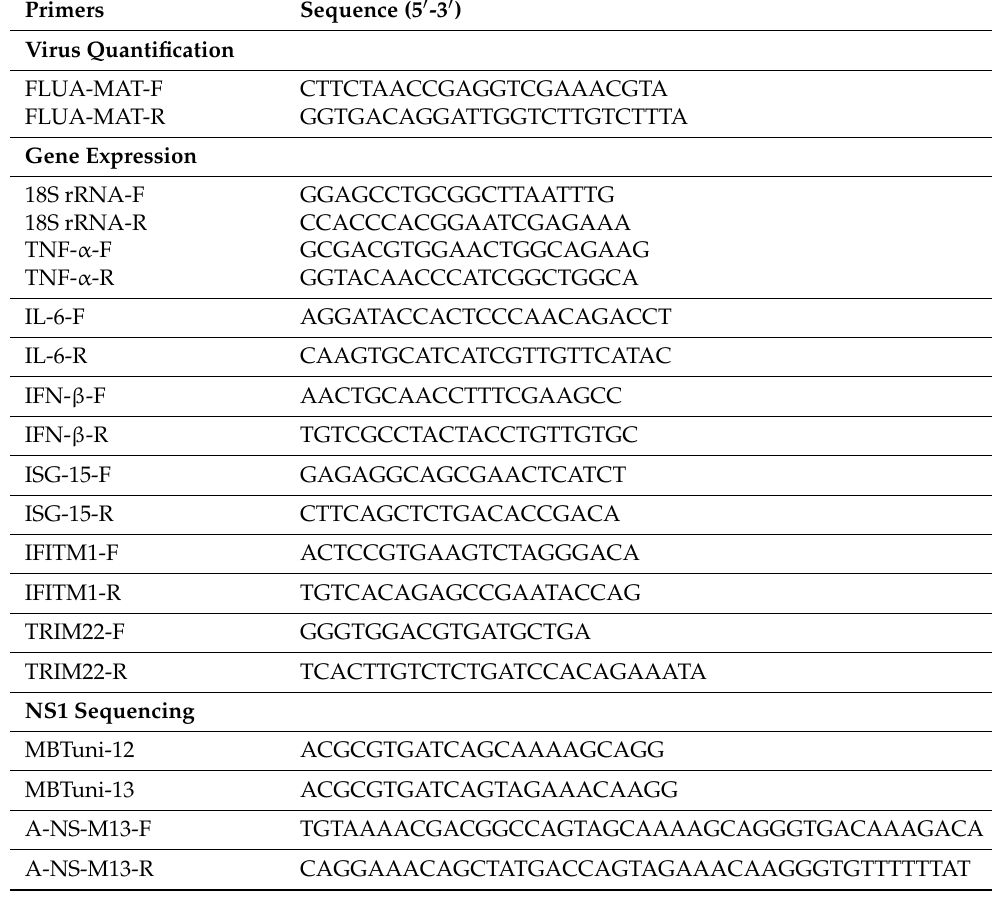
Table 1. List of primers used in this